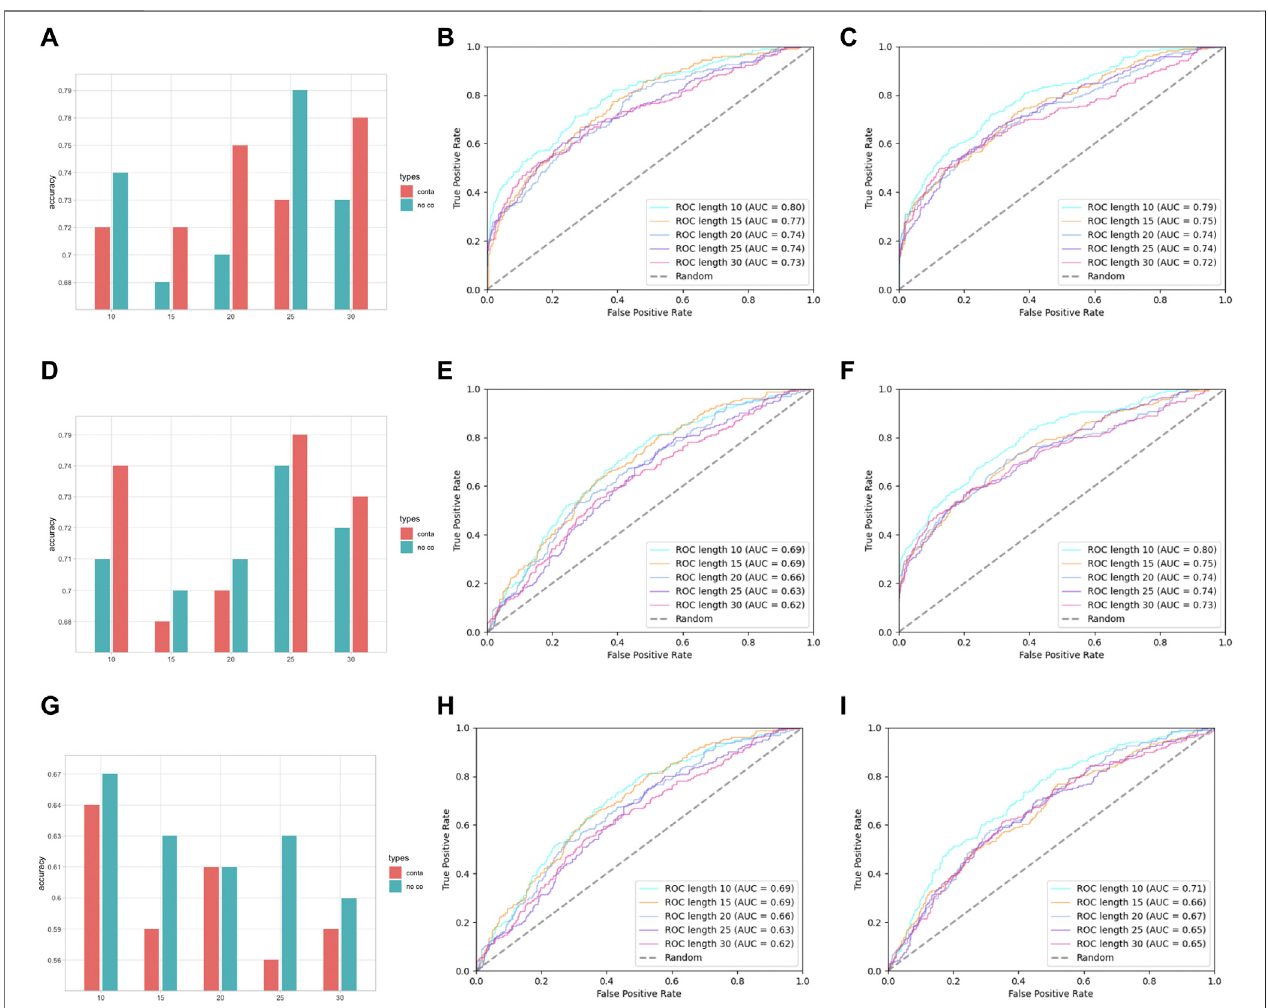
FIGURE 5 | Performance assessment of features AAPC and RRPC. (A) Group barchart of classi fi er SVM of features AAPC and RRPC; (B) ROC of feature AAPC withclassi fi erSVM; (C) ROCoffeatureRRPCwithclassi fi erSVM; (D) groupbarchartofclassi fi erRFoffeaturesAAPCandRRPC; (E) ROCoffeatureAAPCwithclassi fi er RF; (F) ROC of feature RRPC with classi fi er RF; (G) group barchart of classi fi er LR of features AAPC and RRPC; (H) ROC of feature AAPC with classi fi er LR; (I) ROC of featureRRPCwithclassi fi erLR.In (A) , (D) ,and (G) ,theredbarsrefertocontactedinformation,whichcorrespondstotheRRCfeature,whilegreenbarsrefertothe case containing no contacted residues, which corresponds to AAC